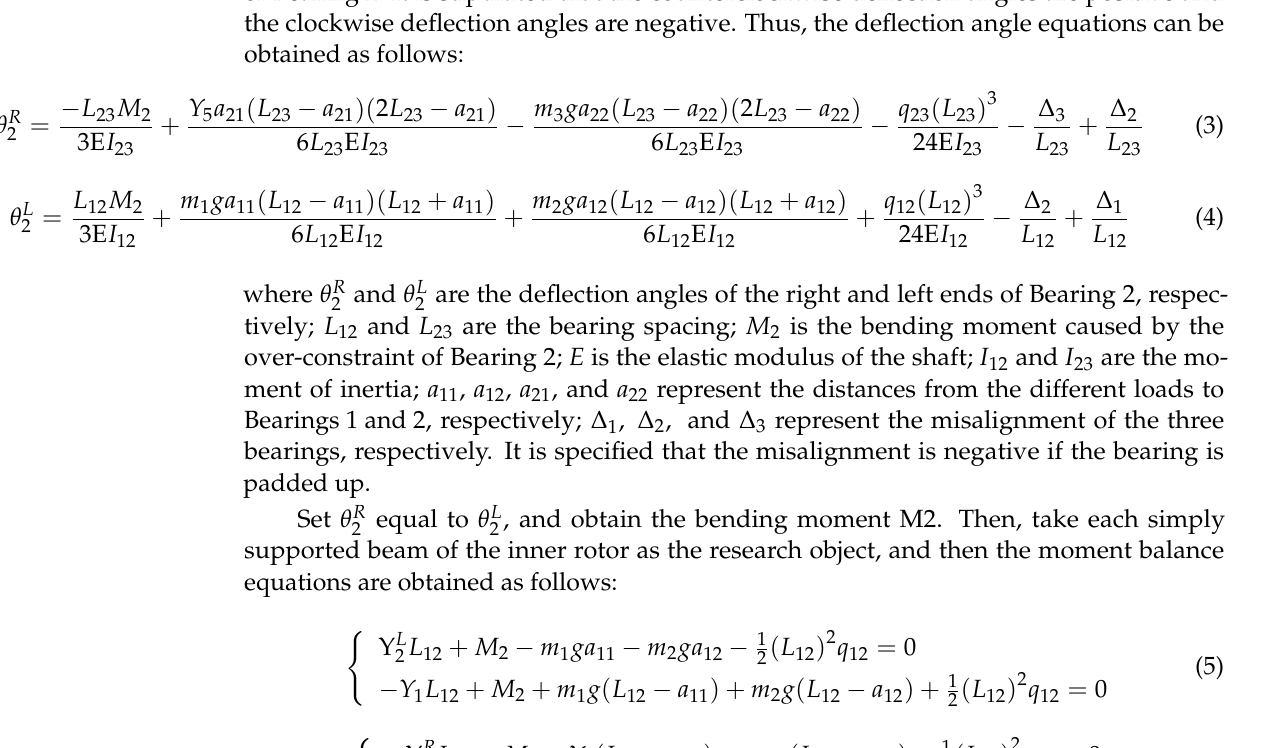
Figure 5. Applied forces of the inner rotor.